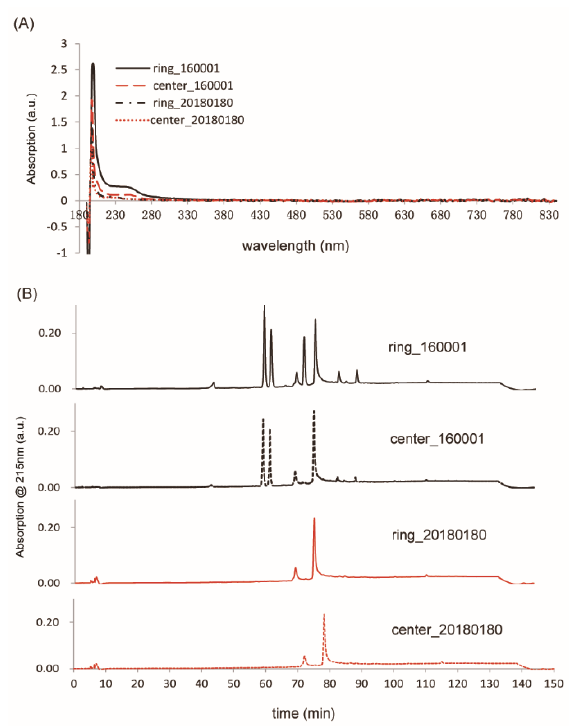
Figure 4. UV–Visible absorption spectroscopic and HPLC analysis of contaminants extracted from collection devices. ( A ) UV–Visible spectra of filter paper discs punched on the ink circle (ring) or inside the ink circle (center) from both contaminated (Lot160001) and new (Lot20180180) collection devices. All extractions have maximum absorption at around 200nm. Extractions of contaminated collection devices have an additional absorption peak around 245 nm. No absorption was observed in the visible wavelength range for all samples. ( B ) HPLC chromatograms of above samples. Two prominent peaks were observed on the chromatograms of samples extracted from contaminated collection devices around 60min elution time, which were absent on samples from new collection devices.